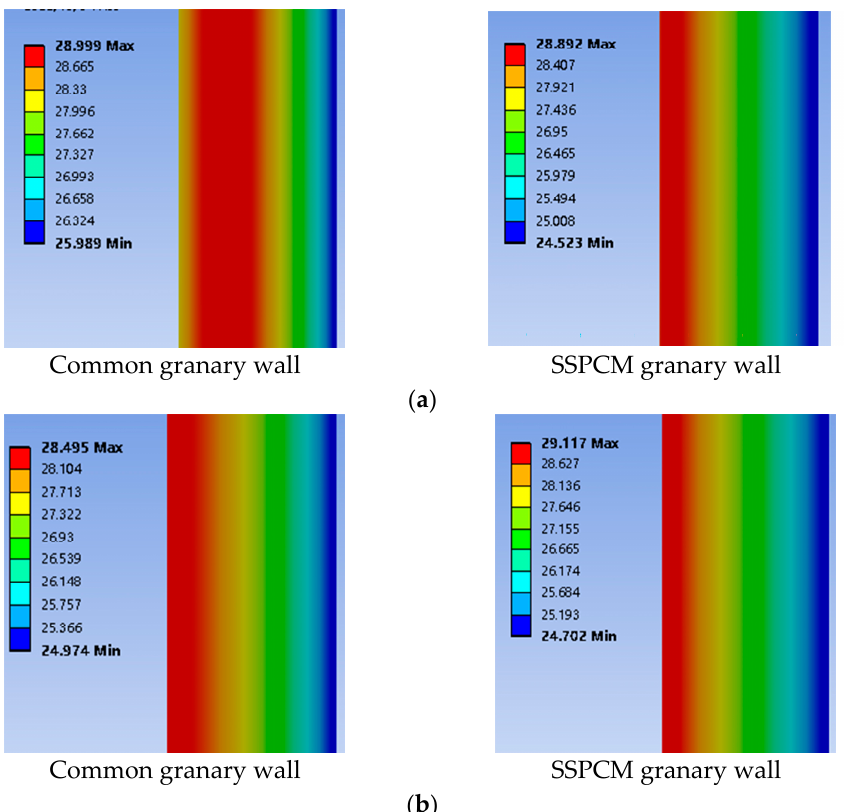
Figure 9. The temperature distribution of the common and SSPCM granary walls at ( a ) T = 72 h (third day) and ( b ) T = 168 h (seventh day).